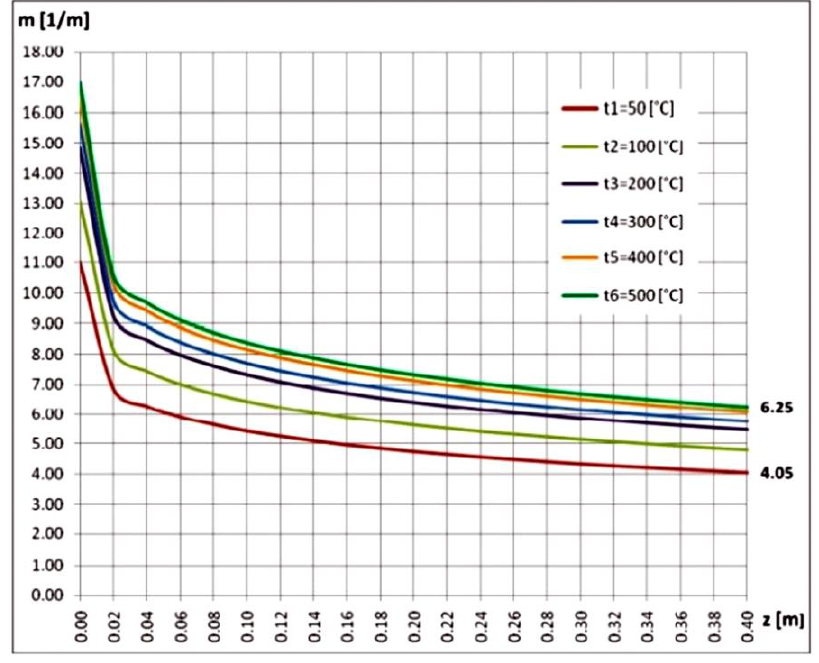
Figure 19. The variation in the parameter “ m ” for the whole length of the bar (cid:96) = z = 0.40 m , corresponding to α g = 90 ◦ .